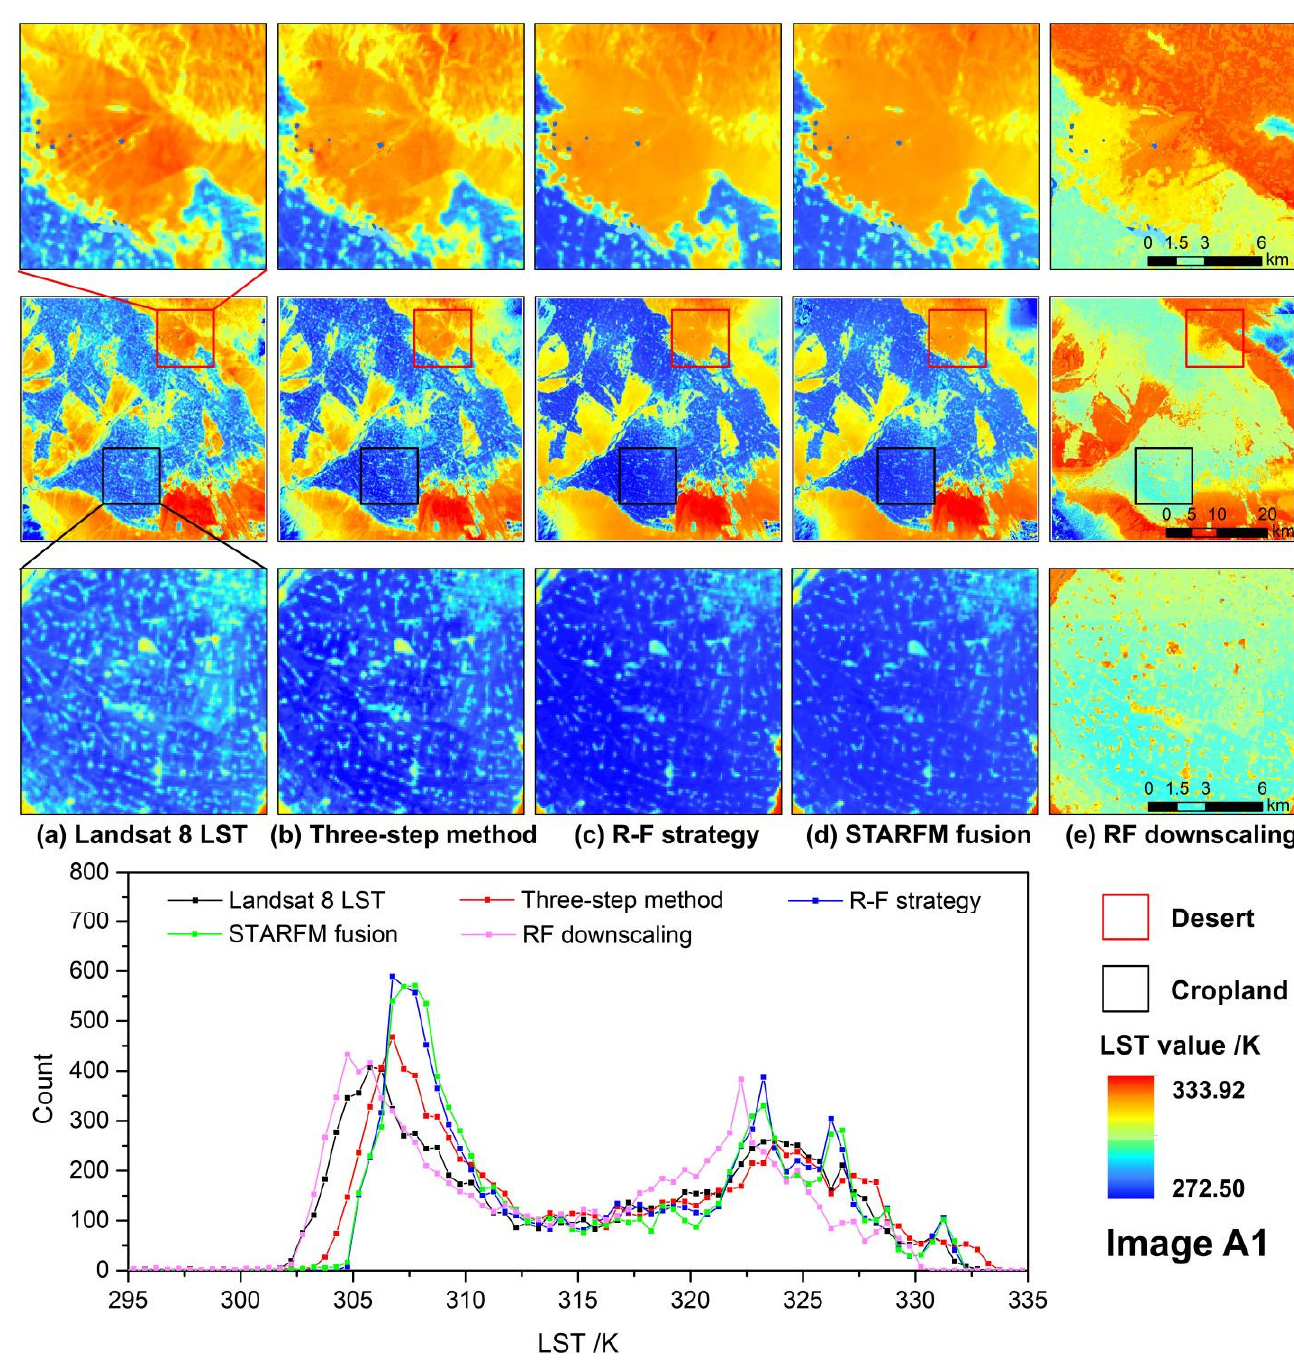
Figure 5. The spatial patterns and frequency distribution curves of predicted LSTs for Image A1: ( a ) Landsat 8 LST product; ( b ) the LST predicted by the three-step method, ( c ) the LST predicted by the RF strategy, ( d ) the LST predicted by the STARFM fusion, ( e ) the LST predicted by the RF downscaling.